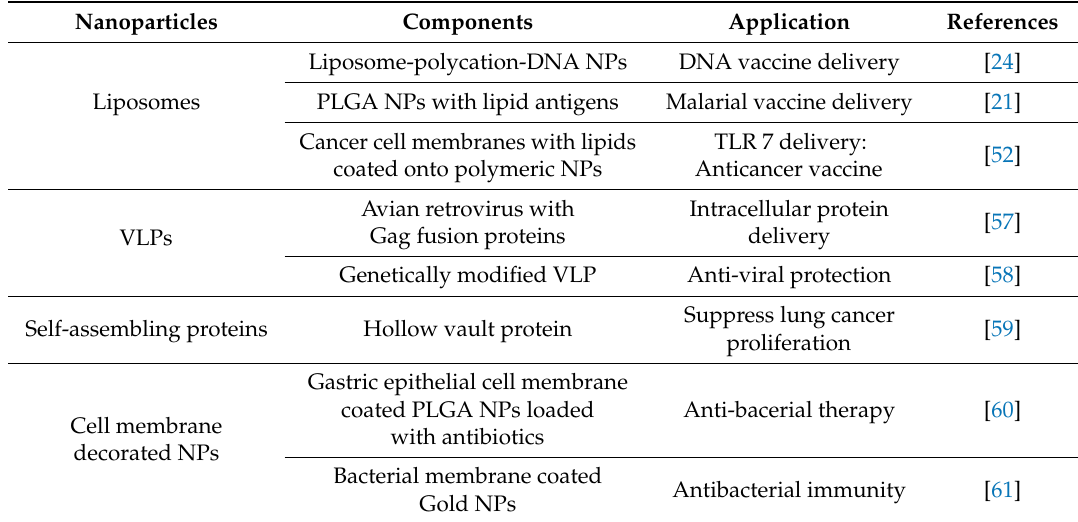
Table 1. Already reported biomimetic nanovaccines and its